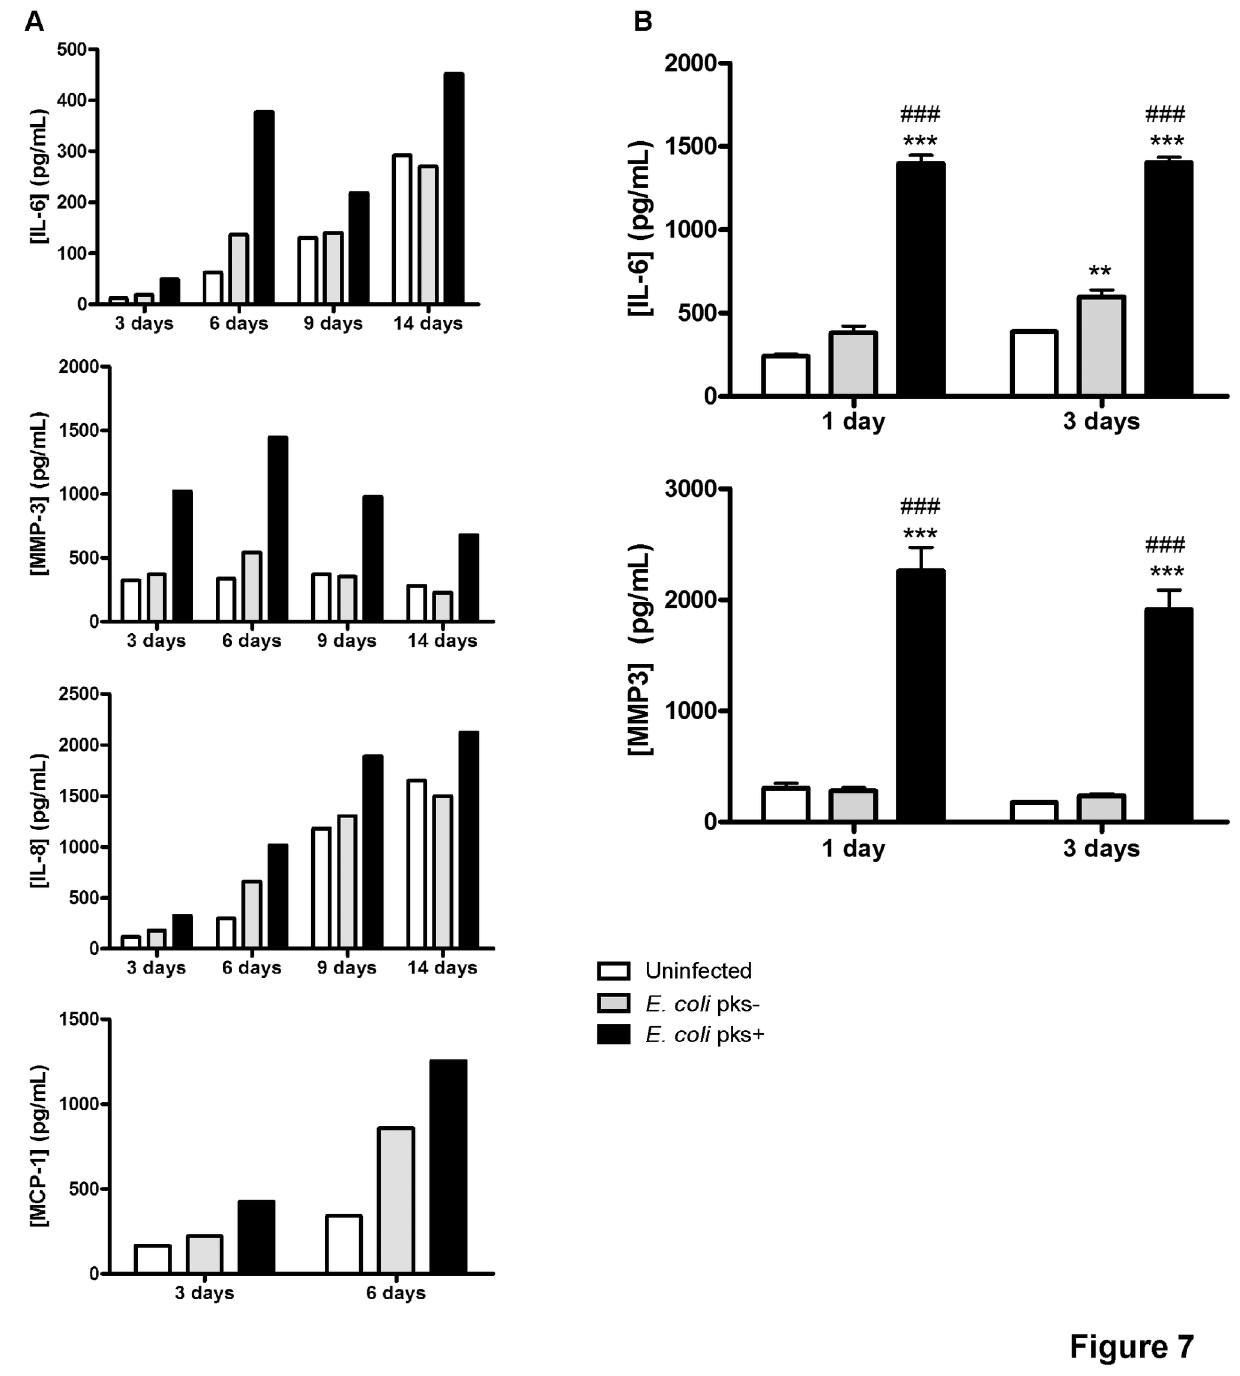
Figure 7. Induction of a senescence-associated secretory phenotype (SASP) in IMR-90 cells following infection with pks + E. coli. IMR-90 cells were infected as before and incubated for 1-14 days. Conditioned cell culture media were prepared by incubating each culture in serum-free medium for 24 h. MMP-3, IL-6, IL-8 and MCP-1 secretion was quantified by Bio-Plex in one experiment (A) and by ELISA in two independent experiments (B) ; Results represent the mean and SEM, one-way ANOVA with Bonferroni’s multiple comparison test; **P<0.01, ***P<0.001 comparing infected and uninfected groups; # # #P<0.001 comparing pks + and pks - groups.